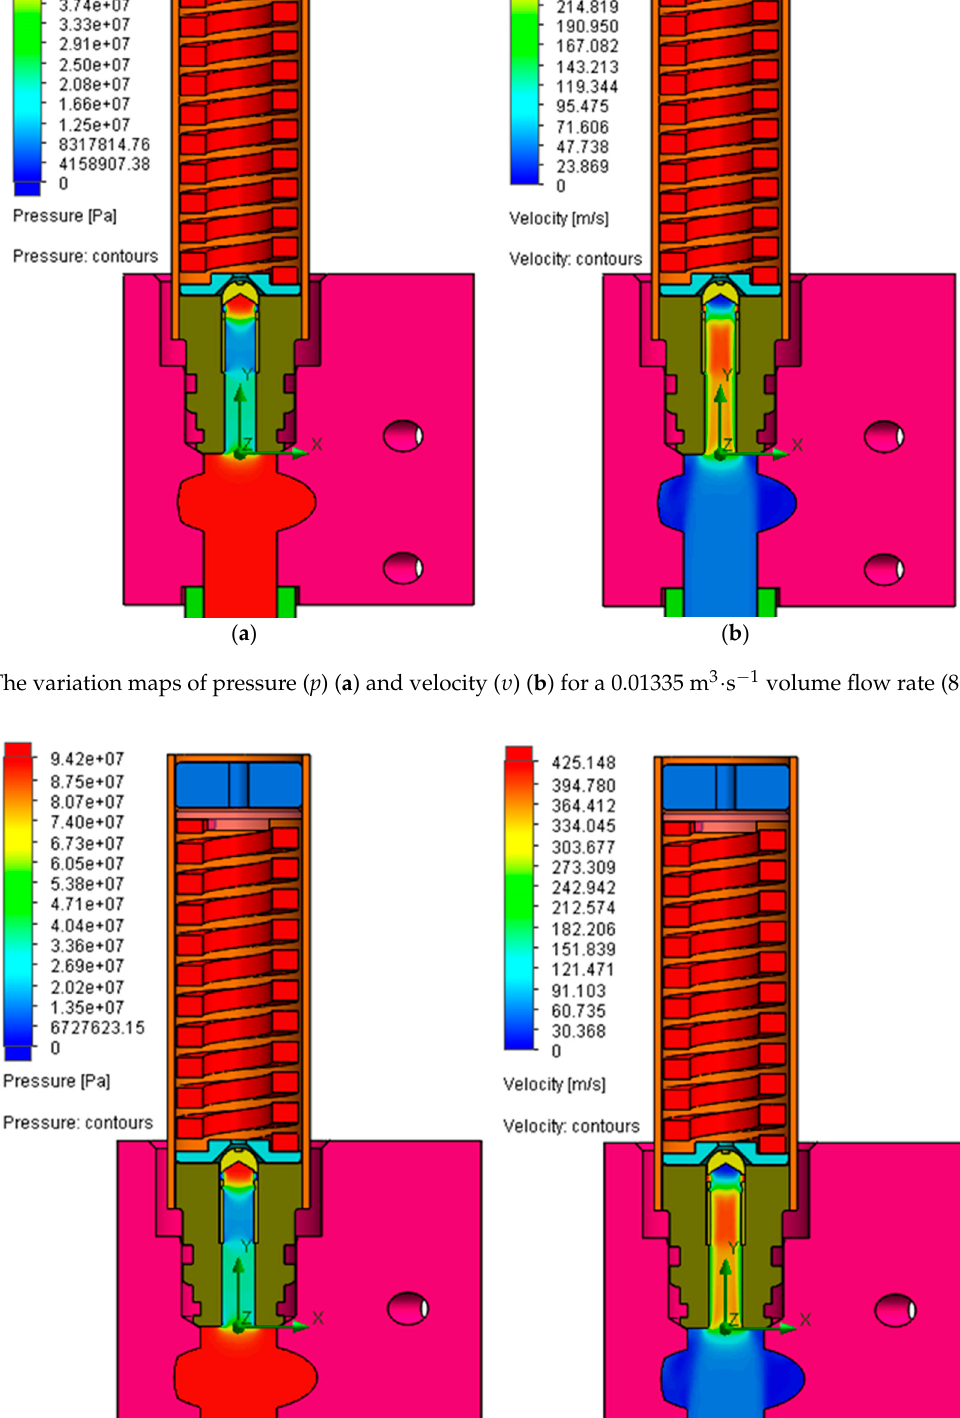
Figure 20. The variation maps of pressure ( p ) ( a ) and velocity ( υ ) ( b ) for a 0.017 m 3 ·s -1 volume flow rate (1020 L·min -1 ).